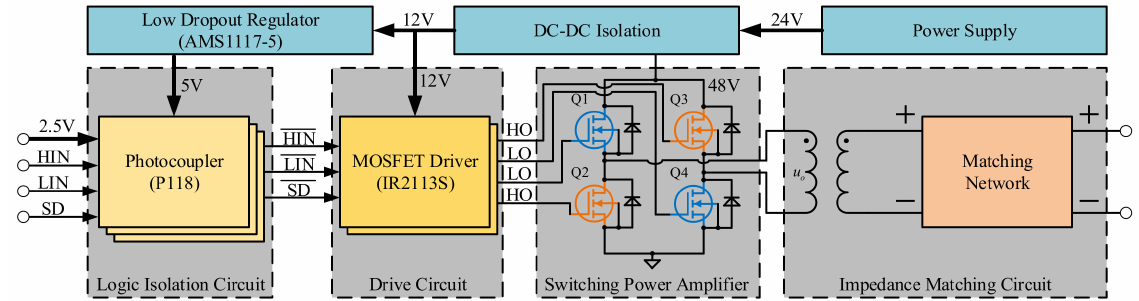
Figure 5. Transmitting module hardware block